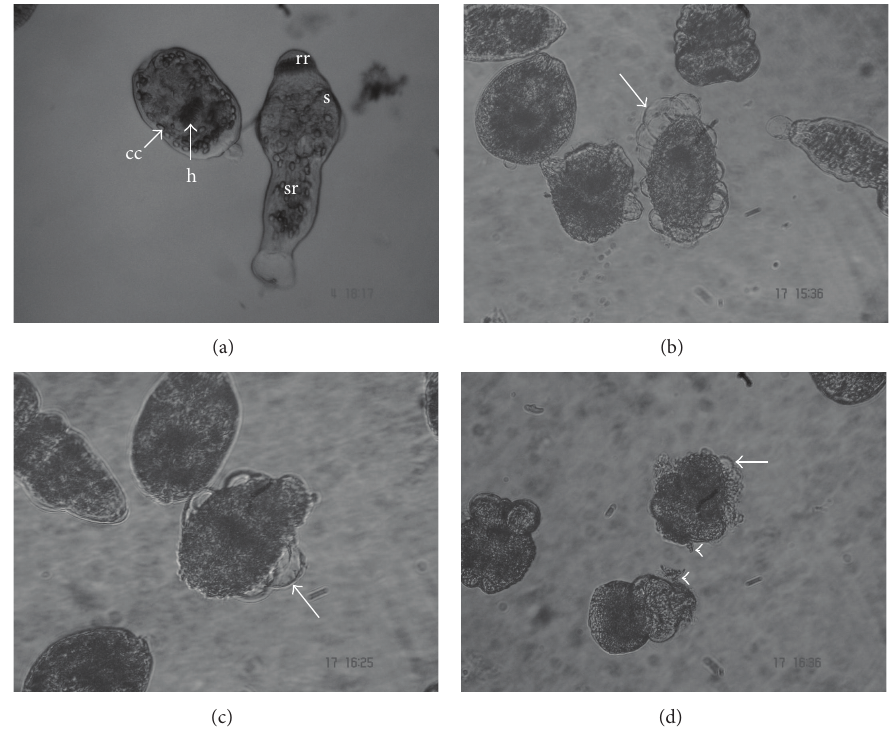
Figure 5: Light microscopy of E. granulosus protoscoleces incubated in vitro with thymol and essential oils of T. vulgaris and O. vulgare . (a) Control protoscoleces (cc: calcareous corpuscles, h: hooks, rr: rostellar region, s: suckers, and sr: soma region; 3 days p.i., 500x). (b)-(c) Note the presence of numerous blebs in the tegument of treated protoscoleces (arrows). (b) T. vulgaris (3 days p.i., 400x). (c) O. vulgare (3 days p.i., 500x). (d) Protoscoleces incubated with thymol during 2 days. The tegument was markedly altered (arrow). Note the loss of hooks (arrowheads, 400x).